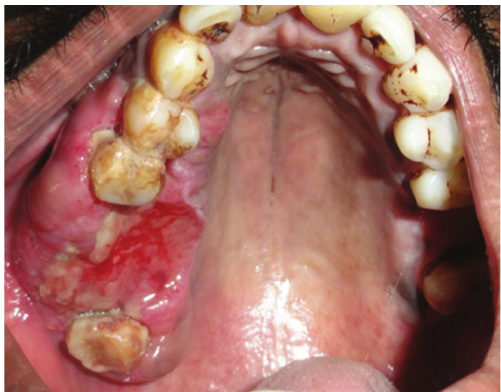
Figure 3: Photomicrograph showing loose collagenous myxoma- tous stroma permeated by spindle shaped cells and nonarborizing blood vessels (hematoxylin and eosin stain, 10x).